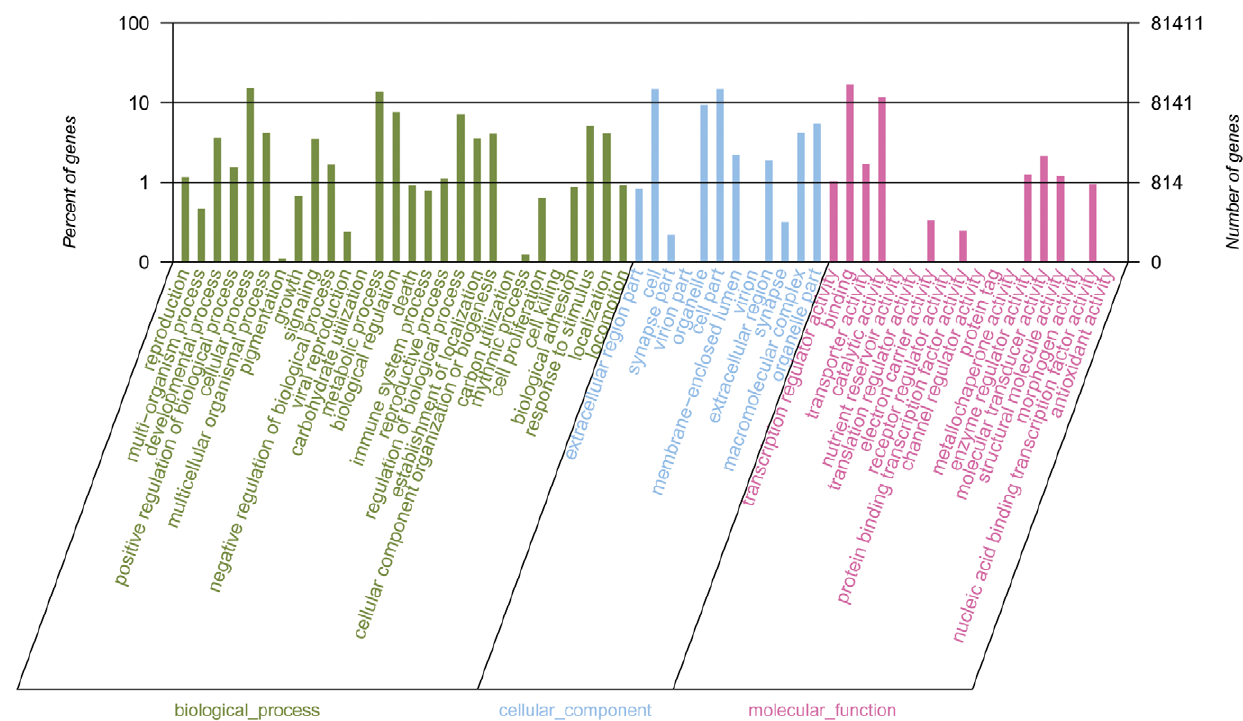
Figure 2. Gene Ontology (GO) terms for the transcriptomic sequences of M.nipponense .